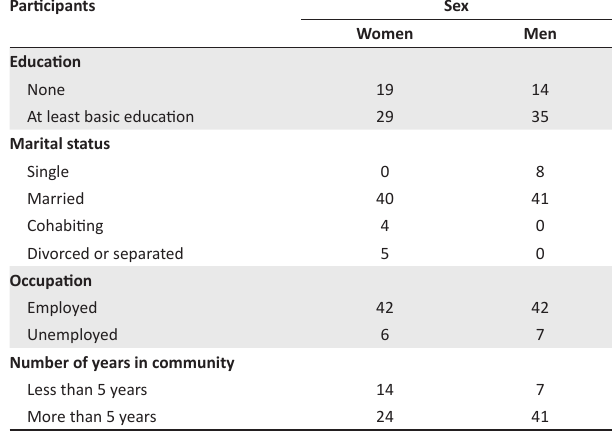
TABLE 2: Background characteristics of focus group discussion participants.